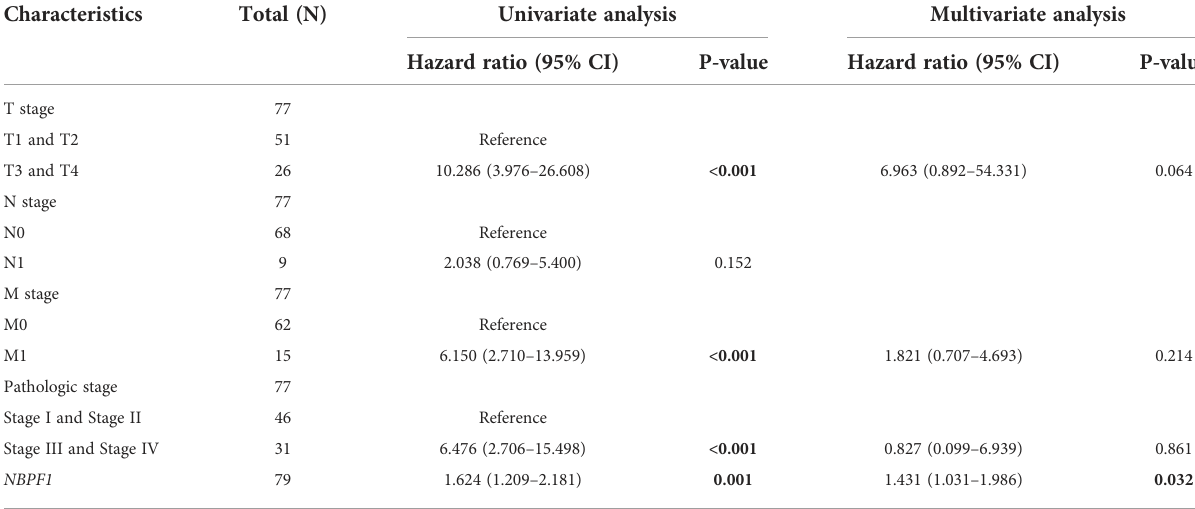
TABLE 1 Univariate and multivariate Cox regression analyses of clinical characteristics associated with OS of ACC.